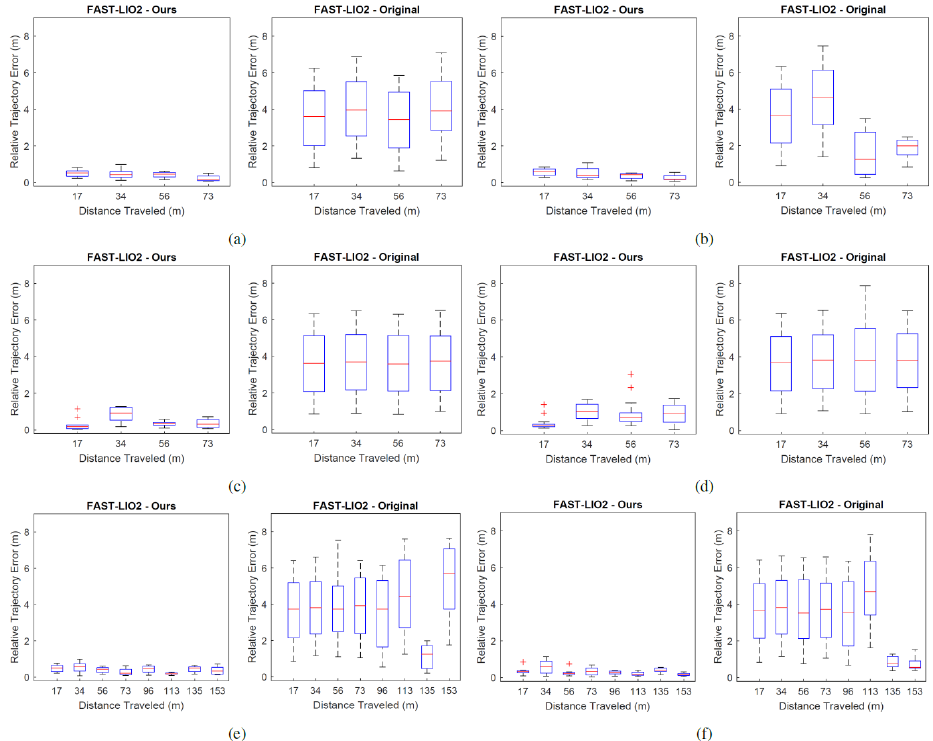
Figure 9. RTE results of the original and improved FAST-LIO2 in the inclined terrain section of the tunnel environment: ( a – d ) single-loop runs, and ( e , f ) double-loop